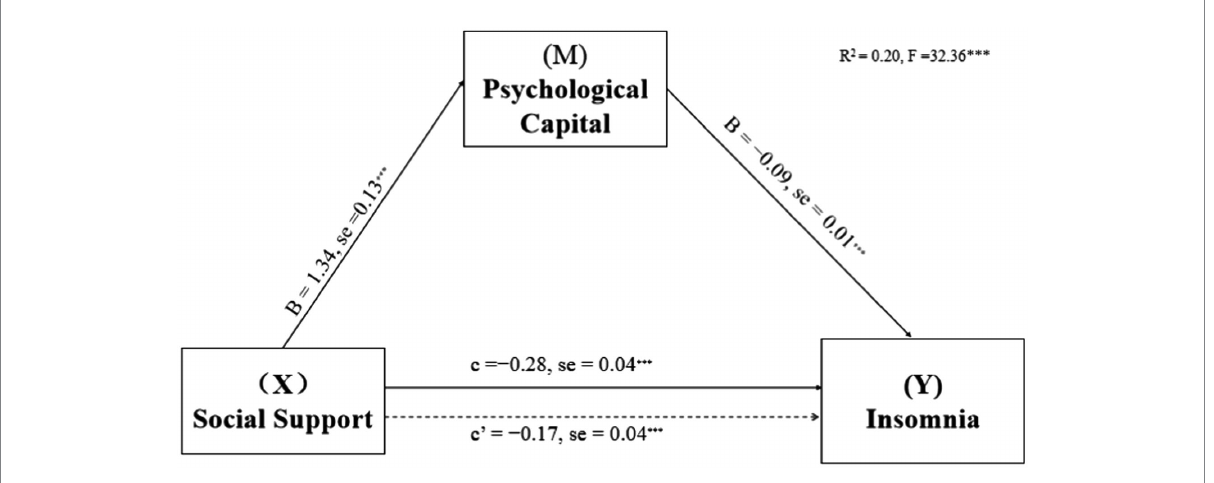
FIGURE 3 Mediation of Psychological capital in the relationship between social support and insomnia symptoms with non-standardized beta values and standard error. *** p < 0.01.